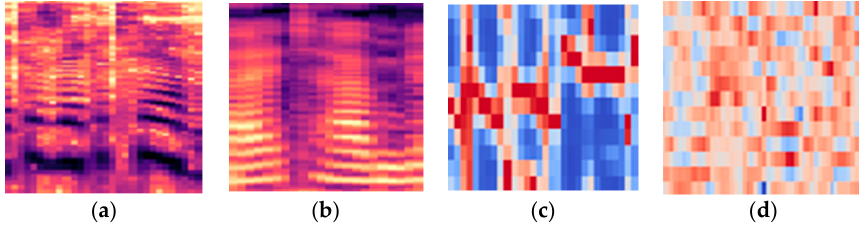
Figure 3. The 2D feature representations of speech signal: ( a ) spectrogram, ( b ) mel spectrogram, ( c ) chromagram, ( d ) MFCC-gram.